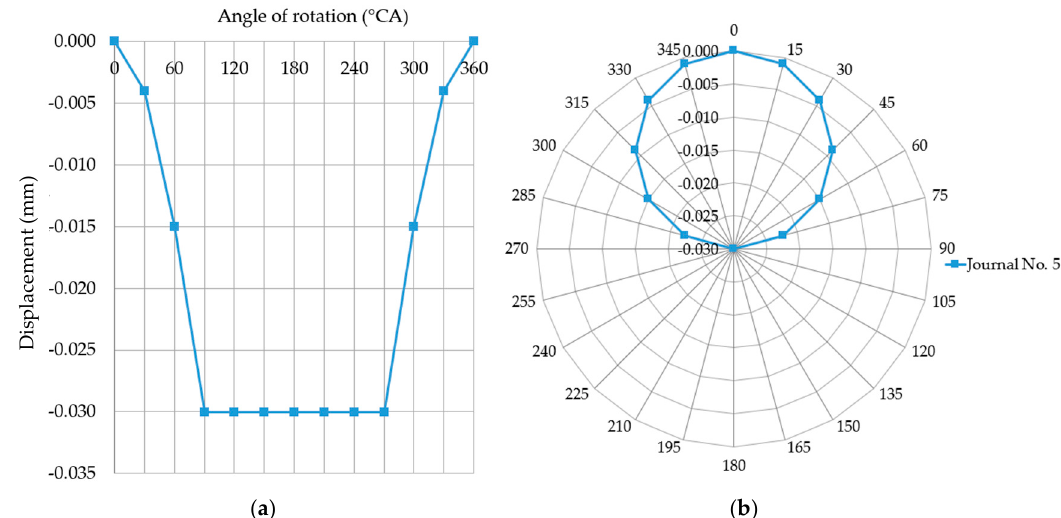
Figure 13. The journal displacements measured by the sensor for a full shaft rotation (0°–360° angle) are recorded when the support maintaining a constant height restricts these displacements, as shown in the ( a ) Cartesian and ( b ) polar coordinate systems.